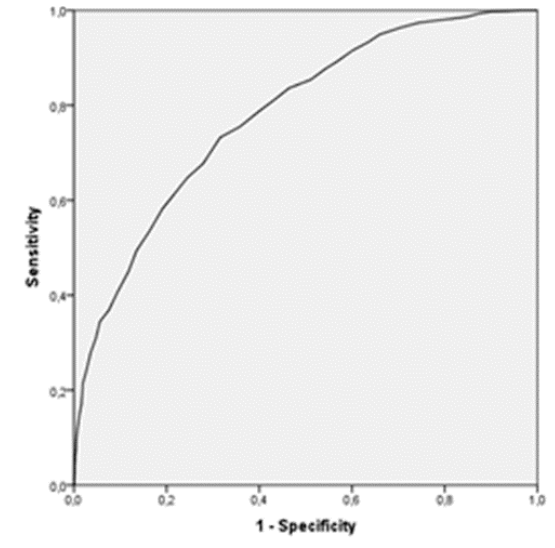
Figure 2. ROC curve. Criterion variable: hours of dedication.